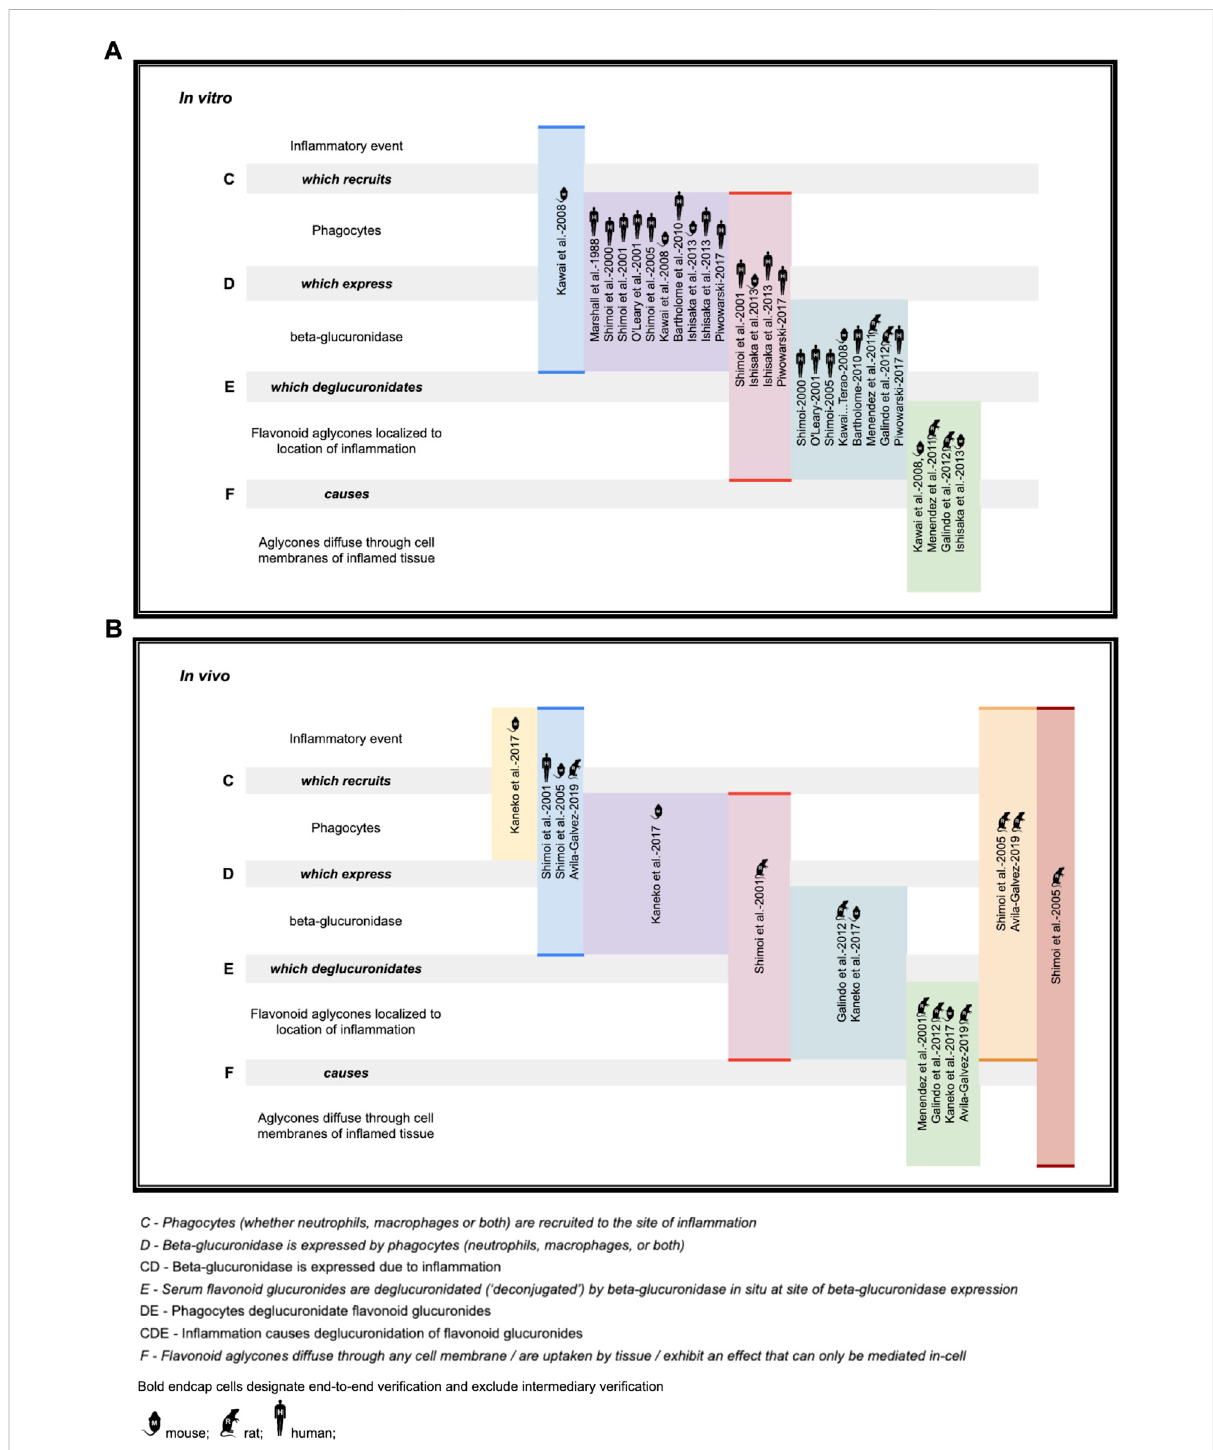
FIGURE 4 Deconjugation-through-in fl ammation literature basis (A) in vitro support (B) in vivo